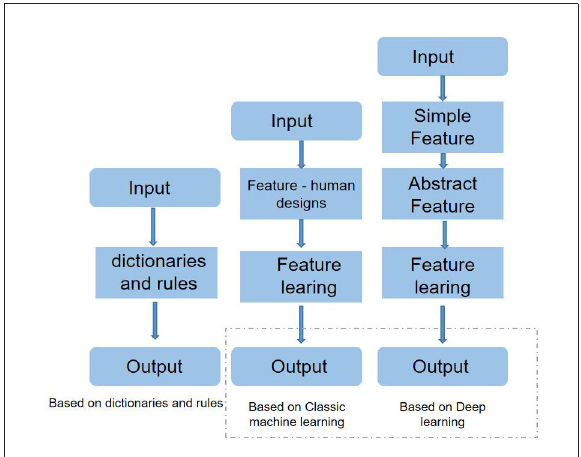
FIGURE1 High-level flow chart of the three methods used for emotion